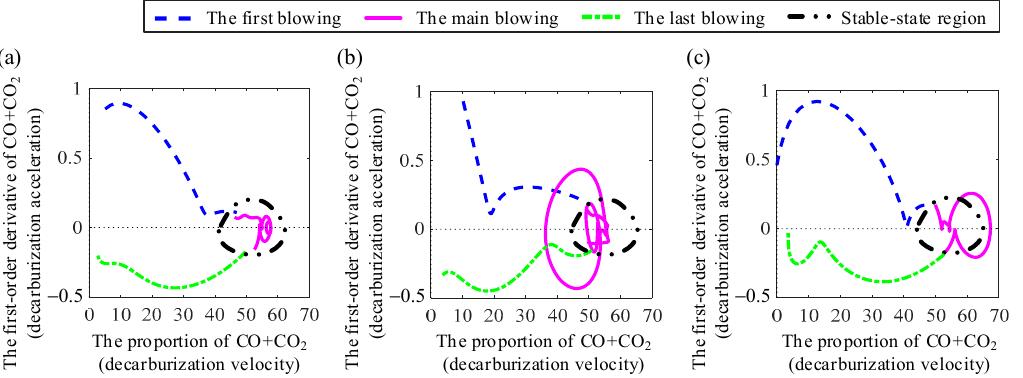
Figure 3. The phase plane of ( a ) normal batch; ( b ) splashing batch; ( c ) drying batch. Figure 3b,c are the phase planes with splashing and drying anomalies respectively.